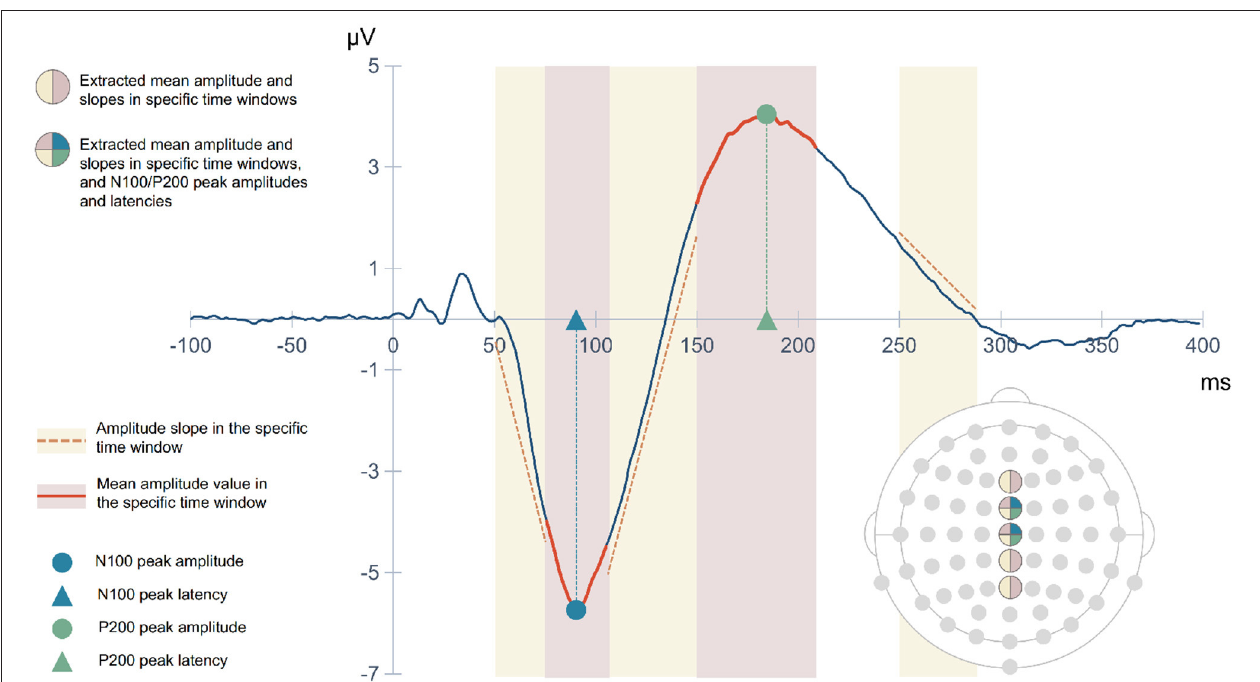
FIGURE 5 | Schematic representation of the features extracted from each subject’s ERP waveform.